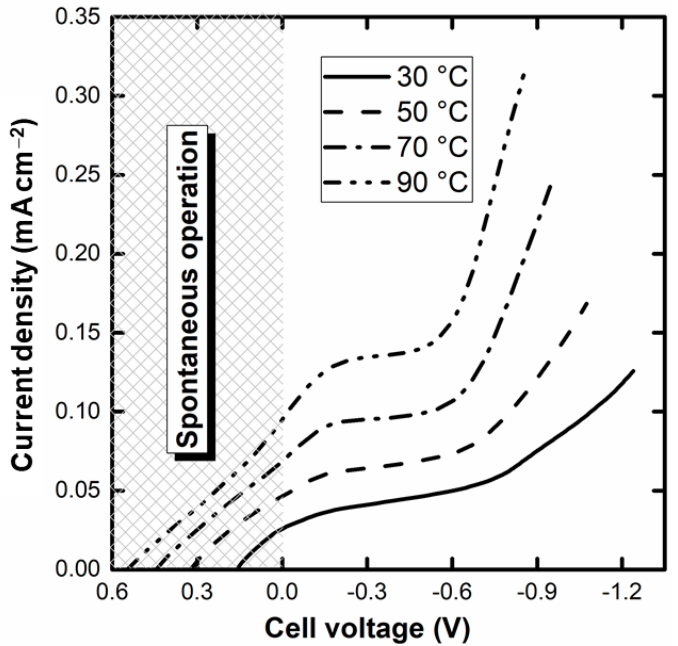
Figure 3. Current-voltage (E HER − E GEOR ) curves of the glycerol alkaline-acid single-cell electrochem- ical reformer at different cell temperatures (voltage window of 1.4 V; anode: 4 mol L − 1 KOH and 1 mol L − 1 glycerol; cathode: 1 mol L − 1 H 2 SO 4 ; electrolyte: Na + -Nafion ® 117 membrane).